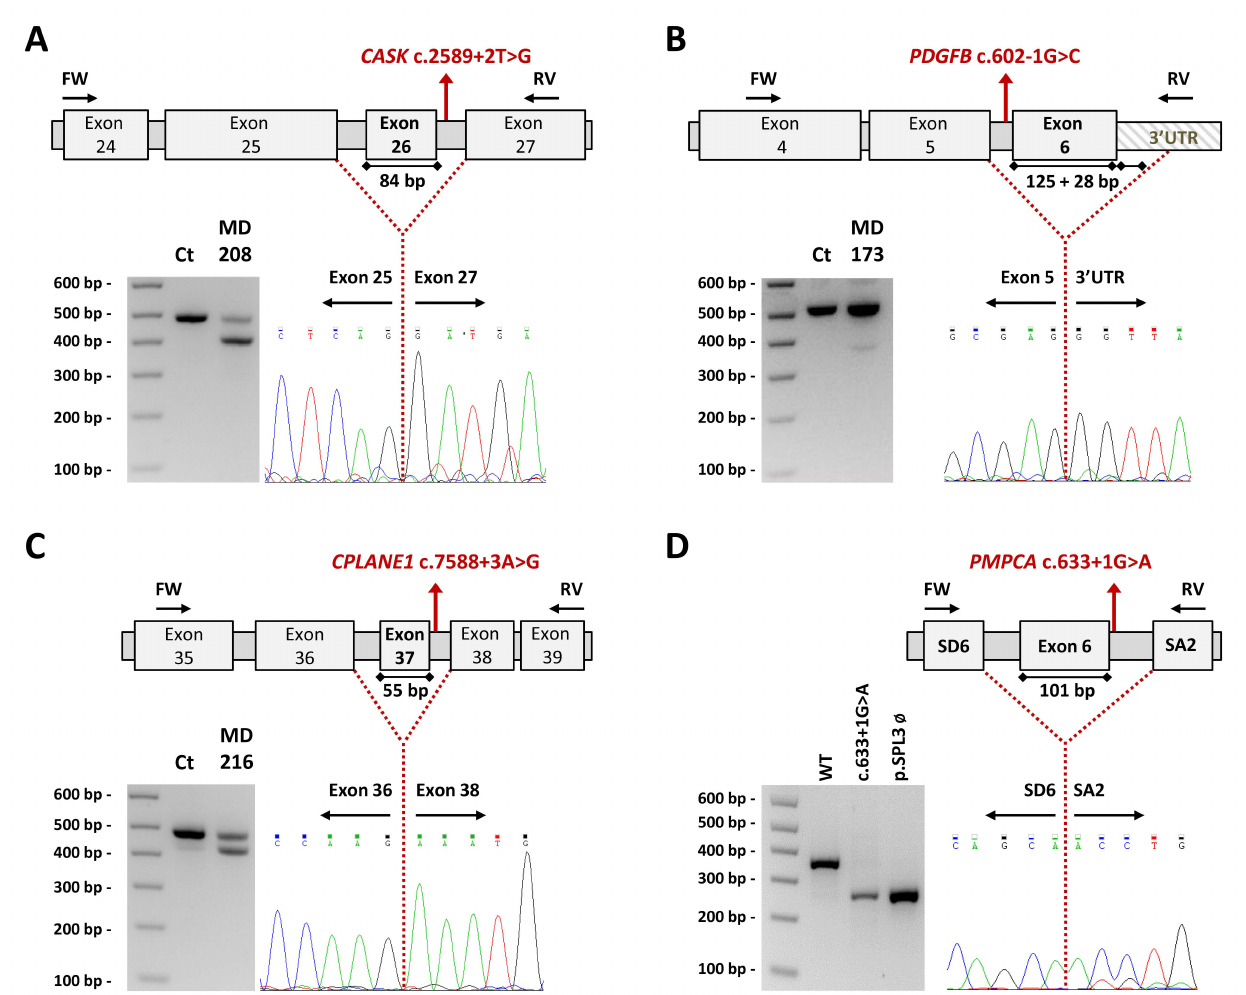
Figure 4. Impact on transcript processing of splicing mutations. Exons are indicated by boxes and introns are represented by horizontal bars (not to scale). Location of specific primers used in RT-PCR is indicated by arrows. Dotted lines represent the anomalous splicing outcome and sequences of the abnormal products are shown (electropherogram). Genomic mutations (in red) are harboured in a heterozygous state and the consensus transcript was also detected in patients’ samples